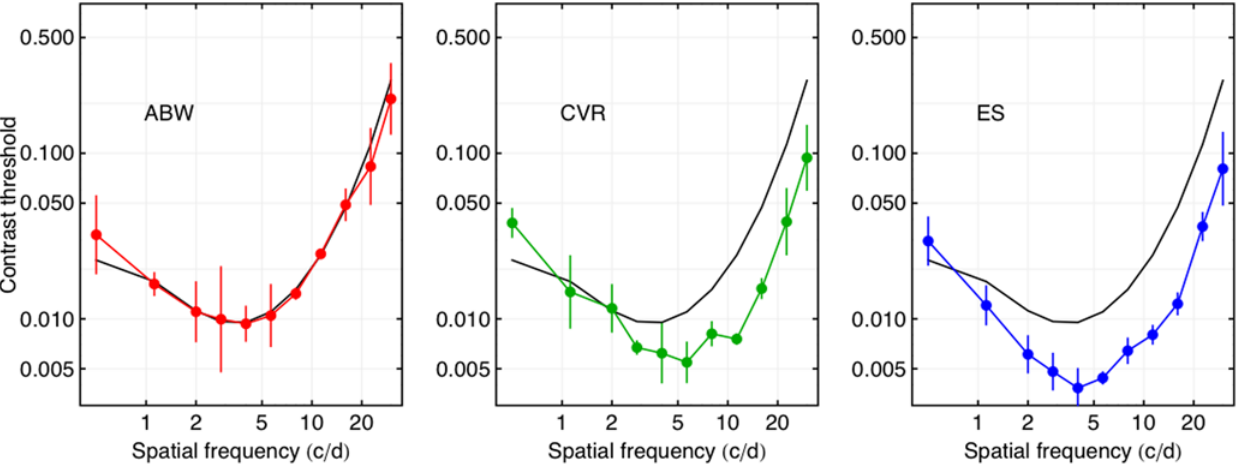
Figure 7. Contrast thresholds for Gabor targets for three observers. The black curve in each panel is the predictions of the SSO. The error bars are plus and minus one standard deviation. The lowest frequency point is for 0 cycles/deg (a simple Gaussian, see Figure 2).